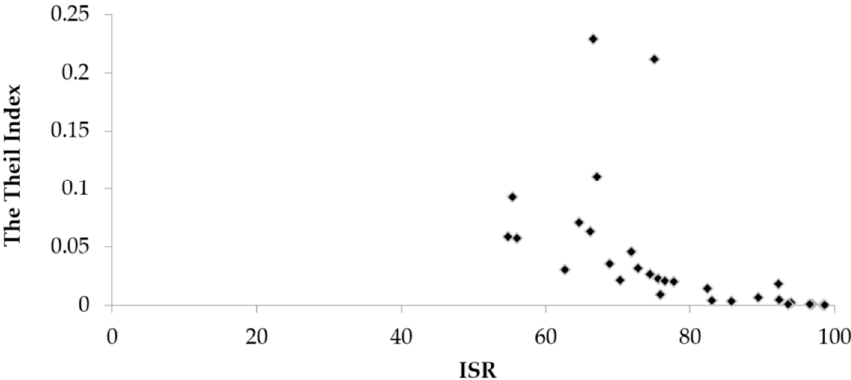
Figure 5. The scatter-plots of the Theil index and ISR among 30 provinces in rural China (2015).